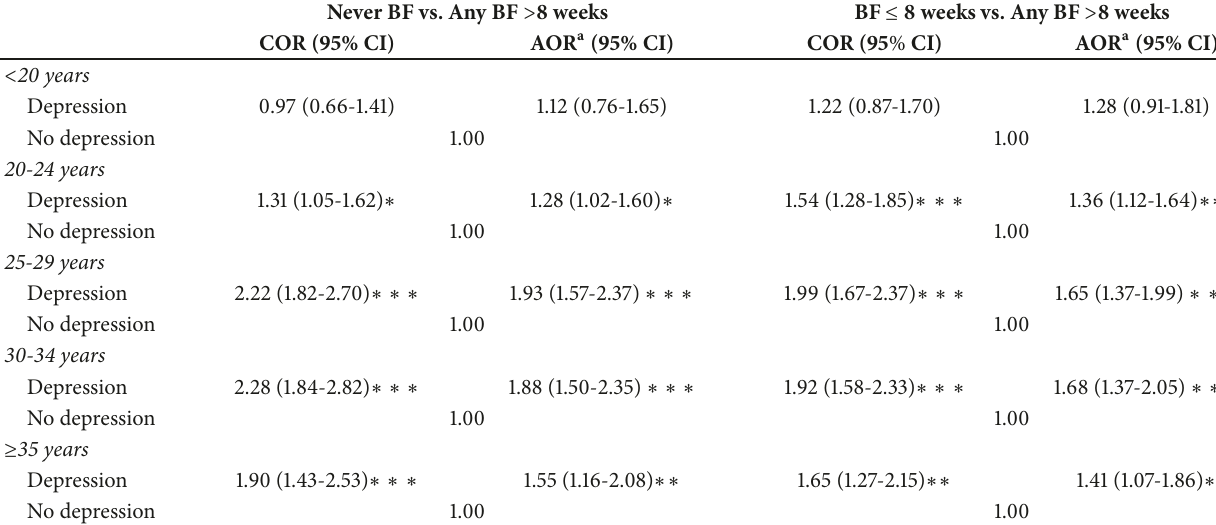
Table 3: Association between prepregnancy depression and breastfeeding duration stratified by